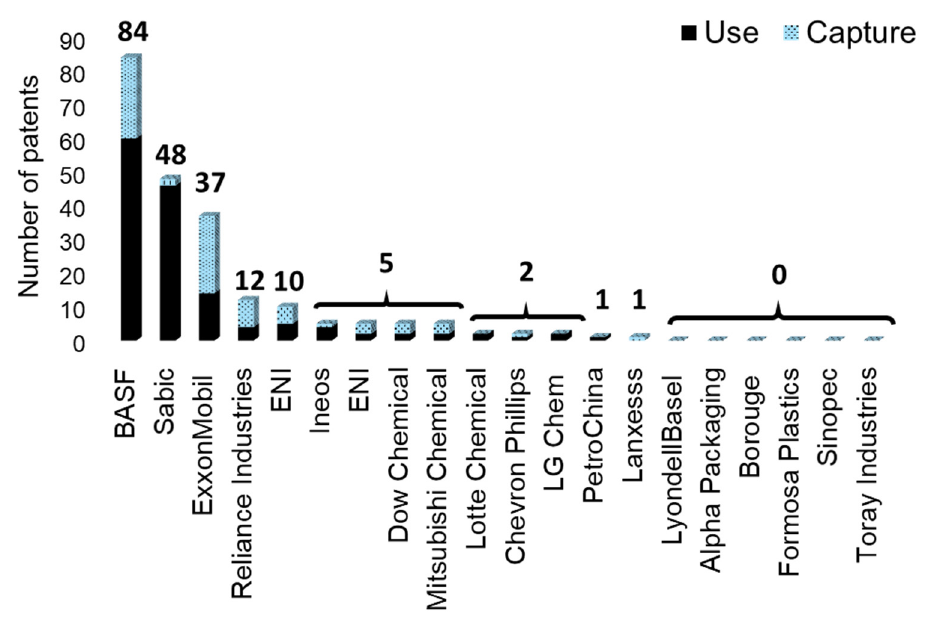
Figure 30. CO 2 capture and use patents for the investigated plastic producers